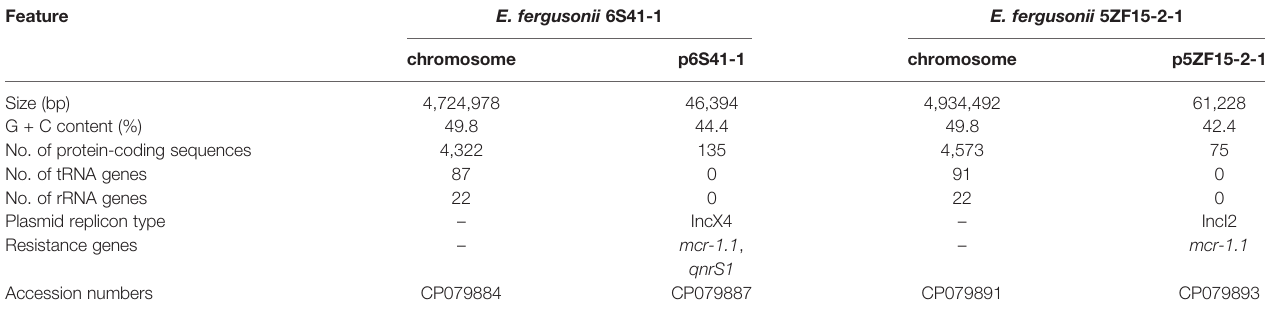
TABLE 2 | Genomic features of the E. fergusonii 6S41-1 and 5ZF15-2-1.